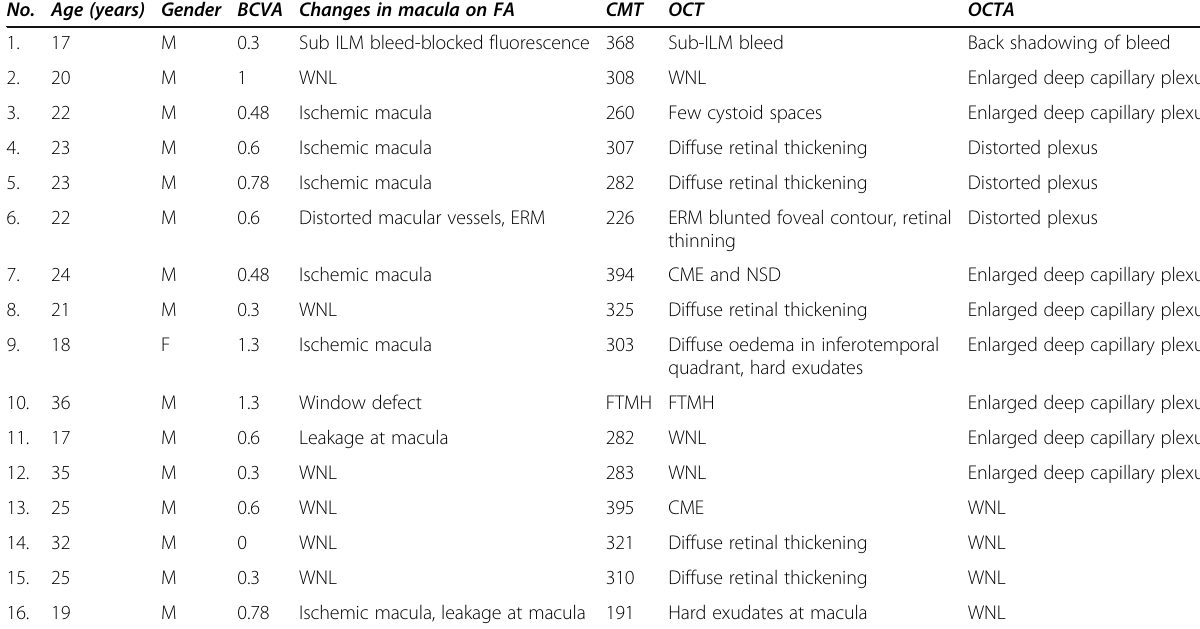
Table 6 Data of patients with macular involvement on FA, OCT and OCTA No. Age (years) Gender BCVA Changes in macula on FA